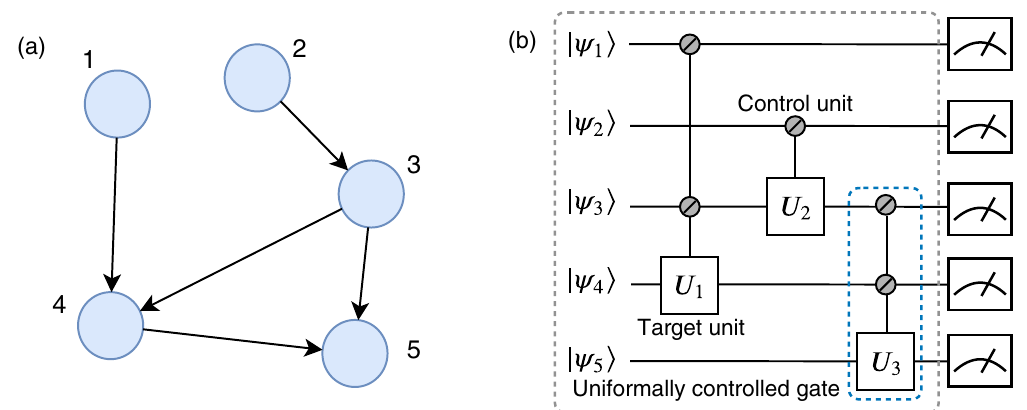
FIG. 9. Bayesian network on a generic graph and its associated Bayesian quantum circuit. (a) Example of a Bayesian network on a generic graph. Each node x corresponds to a transition probability p ð x parents of x ; e.g., the node x 4 corresponds to p ð x 4 j x 1 ; x 3 Þ . If i i j i Þ there is no parent for the node x , it simply corresponds to a marginal probability p ð x ; e.g., the node x 2 corresponds to p ð x 2 Þ . The joint i i Þ probability distribution defined by the Bayesian network is the product of the transition or marginal probability over all of the nodes. For this example, the probability distribution is p ð x 1 ; x 2 ; x 3 ; x 4 ; x 5 Þ ¼ p ð x 1 Þ p ð x 2 Þ p ð x 3 j x 2 Þ p ð x 4 j x 1 ; x 3 Þ p ð x 5 j x 3 ; x 4 Þ . (b) Associated Baye- sian quantum circuit. Each node in the Bayesian network corresponds to a qubit, and each uniformly controlled gate corresponds to a transition probability. For example, the uniformly control- U 2 gate corresponds to p ð x 4 j x 1 ; x 3 Þ . The marginal probabilities p ð x 1 Þ ; p ð x 2 Þ have been absorbed into j ψ 1 i ; j ψ 2 i . Because all Bayesian networks are associated with directed acyclic graphs, an ancestor of a node cannot also be a child of the same node. This means, in Bayesian quantum circuits, there cannot be a target unit after a control unit. Furthermore, the target unit can only involve one qubit in a uniformly controlled gate. Measuring the output qubits of Bayesian quantum circuits in the computational basis will produce the same probability distribution as the corresponding Bayesian